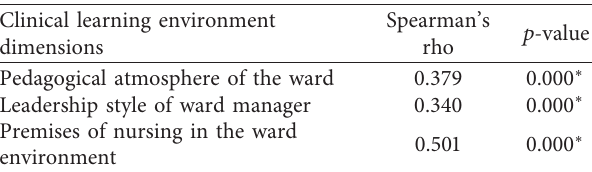
Table 6: Relationship between students’ satisfaction with clinical rotation experience and dimensions of the clinical learning